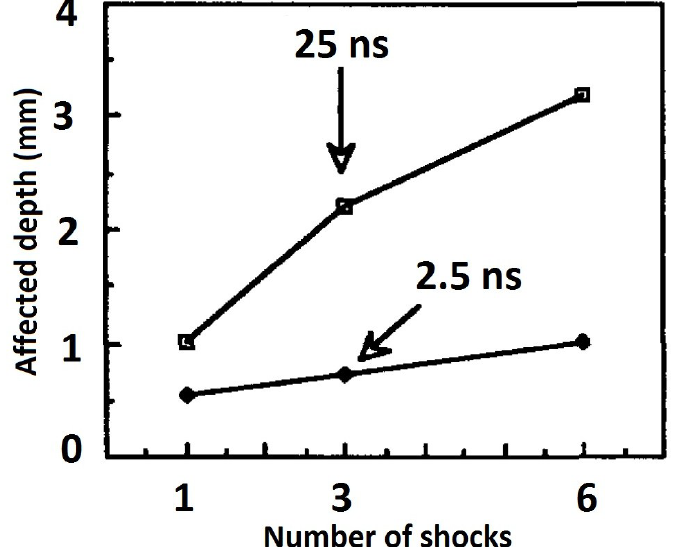
Figure 11. Residual stress depth as a function of pulse duration